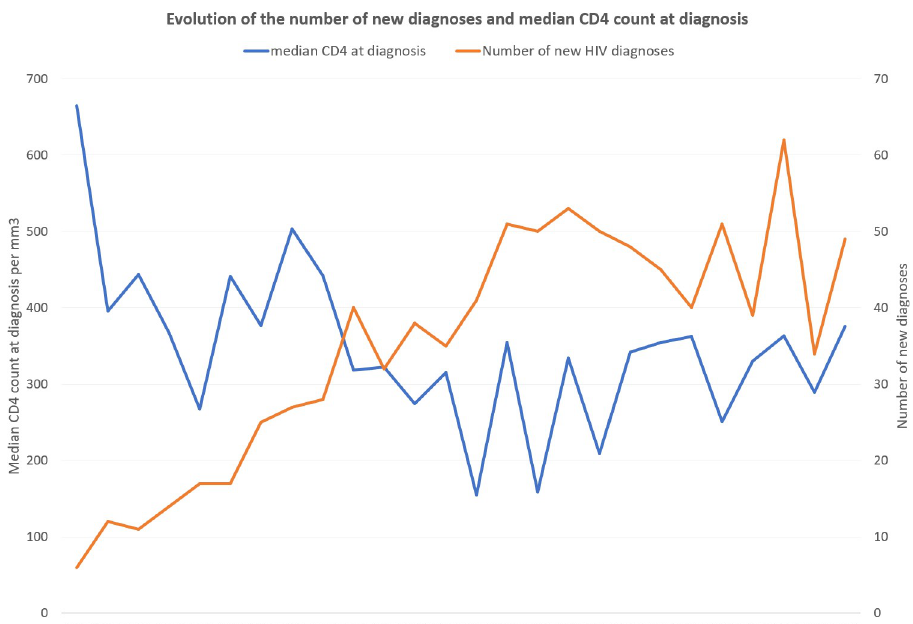
Fig 2. Evolution of the number of new diagnoses and median CD4 count at